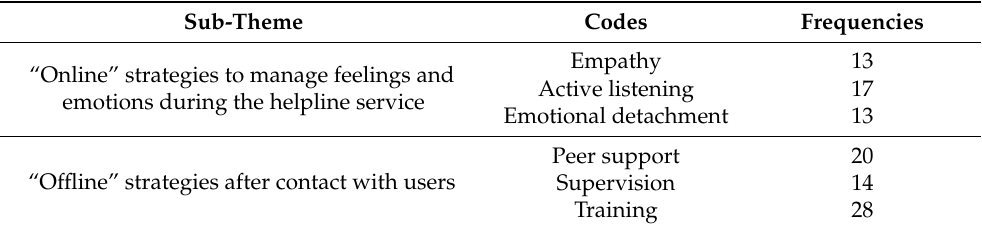
Table 5. Theme 3: “Strategies adopted by operators”, sub-themes, codes that emerged and re- lated